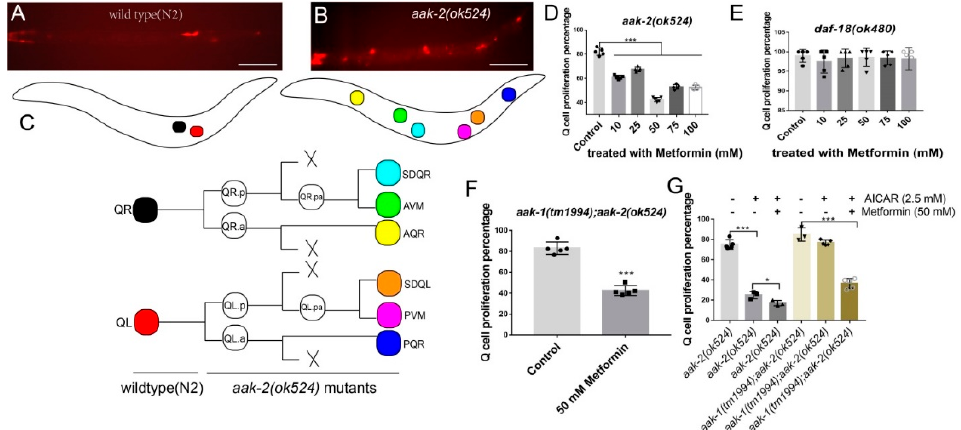
Figure 1. Metformin suppresses neuronal Q-cell divisions in AMP-activated protein kinase (AMPK) deficient L1-arrested worms. ( A ) Wildtype (N2) L1-arrested worms only have two Q cells. ( B ) aak-2(ok524) mutants show Q-cell divisions during L1 arrest and all six Q-cell decedents are present. ( C ) Q cells in wildtype (N2) and aak-2(ok524) L1-arrested worms; the colors of the cells in the cartoon worms are the same in the cell lineage figure. ( D ) Here, 50 mM metformin has the strongest suppression towards Q-cell divisions in aak-2(ok524) mutants during L1 arrest. ( E ) Metformin has no effect on Q-cell divisions in daf-18(ok480) mutants during L1 arrest. ( F ) Metformin has a suppressive function on Q-cell divisions, even when AMPK is totally abolished. Metformin can suppress the Q-cell divisions in aak-1(tm1944) ; aak-2(ok524) double mutants. ( G ) Metformin works differently from AICAR, suggesting it may not work directly on AMPK. AICAR is an AMPK activator and works directly on AMPK. AICAR has no effect on aak-1(tm1944) ; aak-2(ok524) double mutants, while metformin can further suppress the Q-cell divisions in rapamycin-treated aak-1(tm1944) ; aak-2(ok524) double mutants. Data are the average of five independent experiments. Error bars: standard deviation (SD). *: p < 0.05, ***: p < 0.001. Scale bars: 50 µ